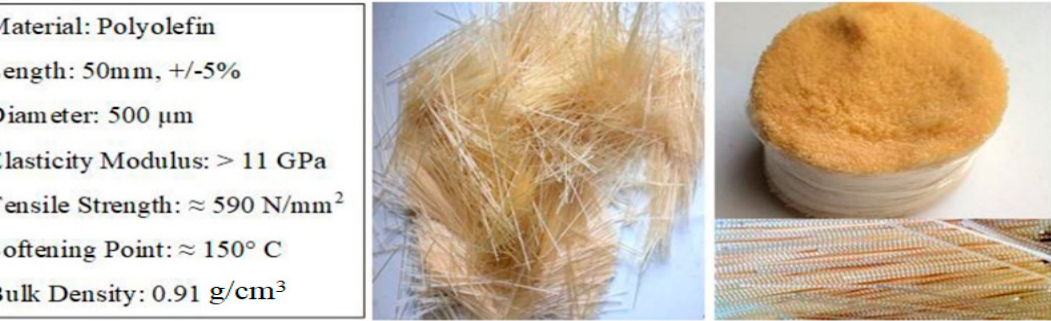
Figure 1. Properties of polyolefin macro fibers.